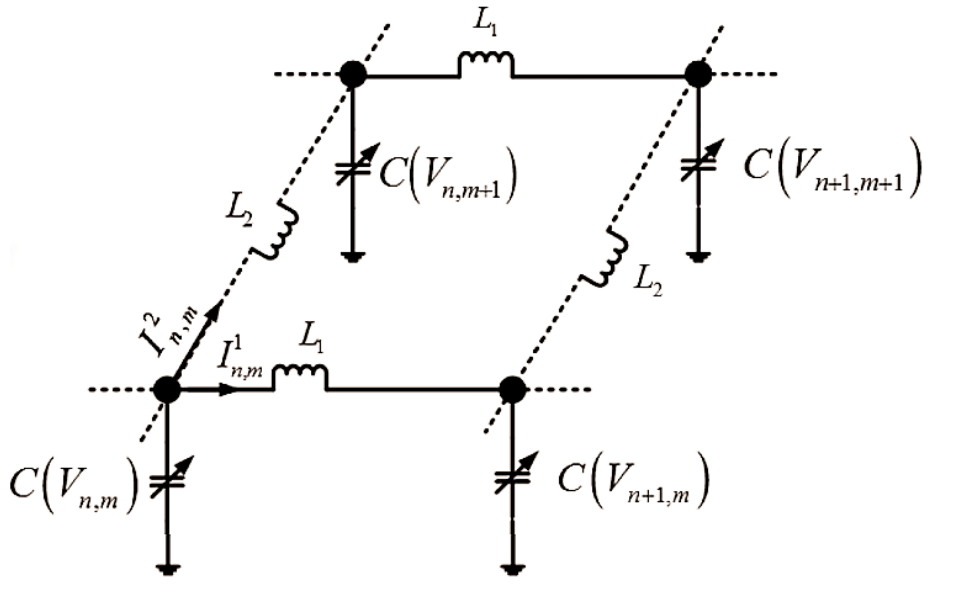
Figure 1. The fractional nonlinear electrical transmission lattice may be experienced